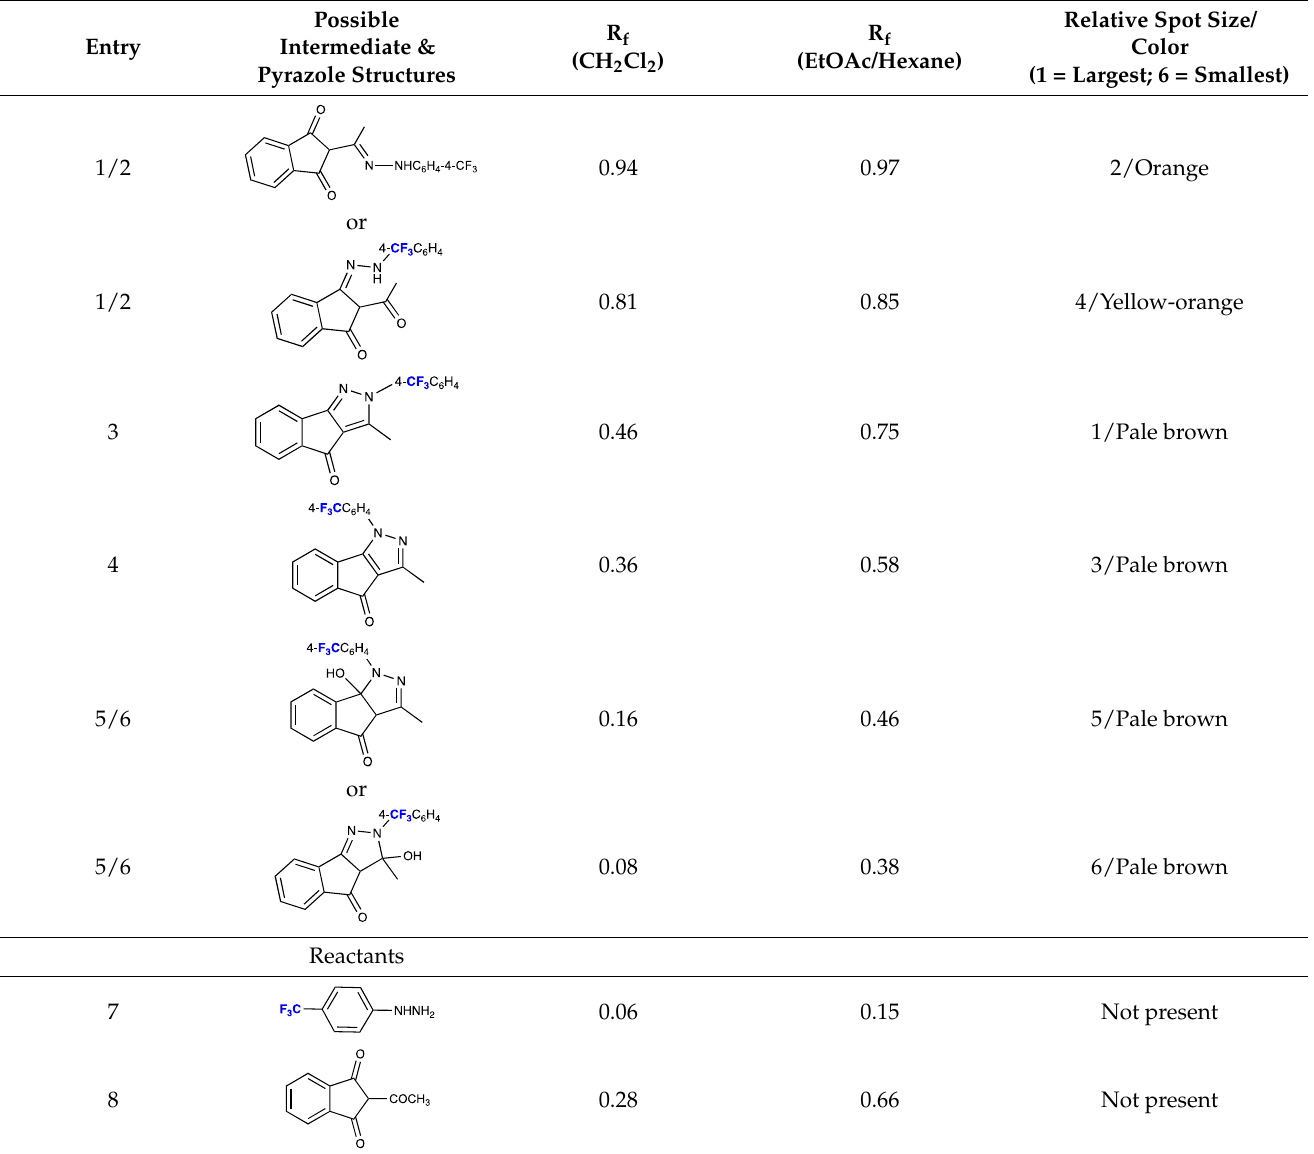
Table 1. Measured TLC R f values for conventional run 1 crude reaction mixture.